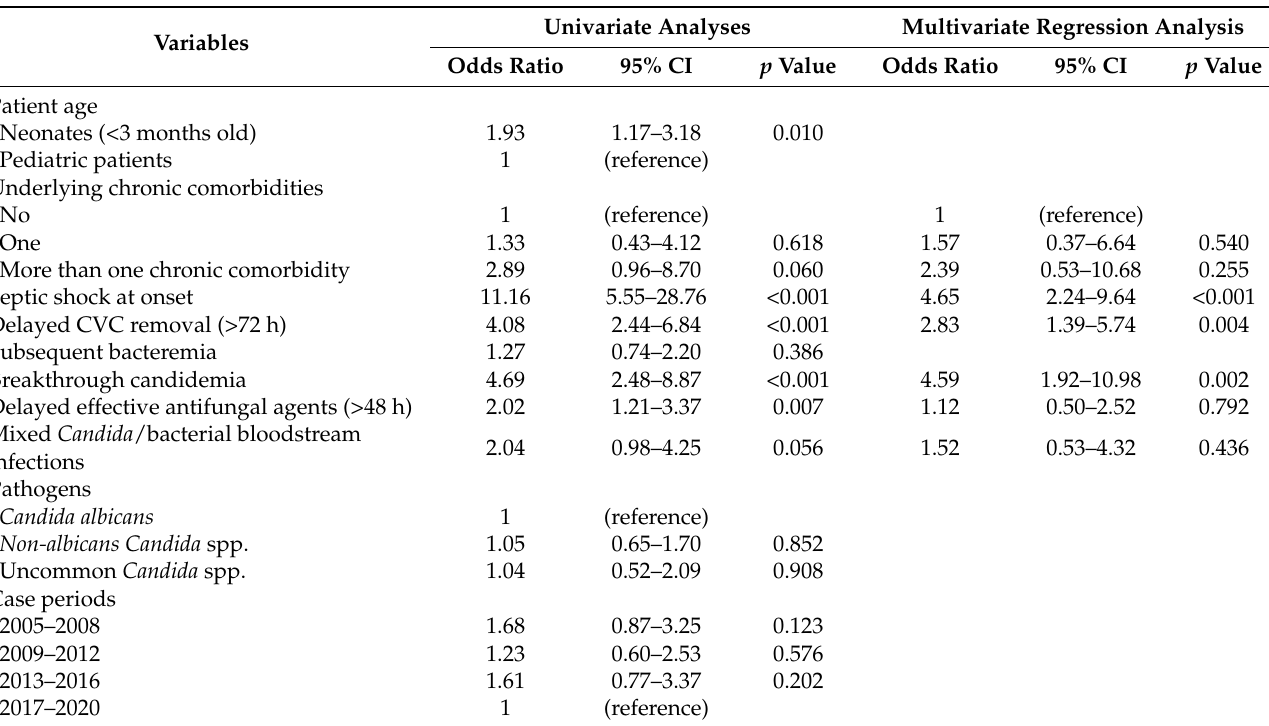
Table 4. Univariate and multivariate logistic regression analysis for independent risk factors of candidemia-attributable mortality in pediatric patients with Candida bloodstream